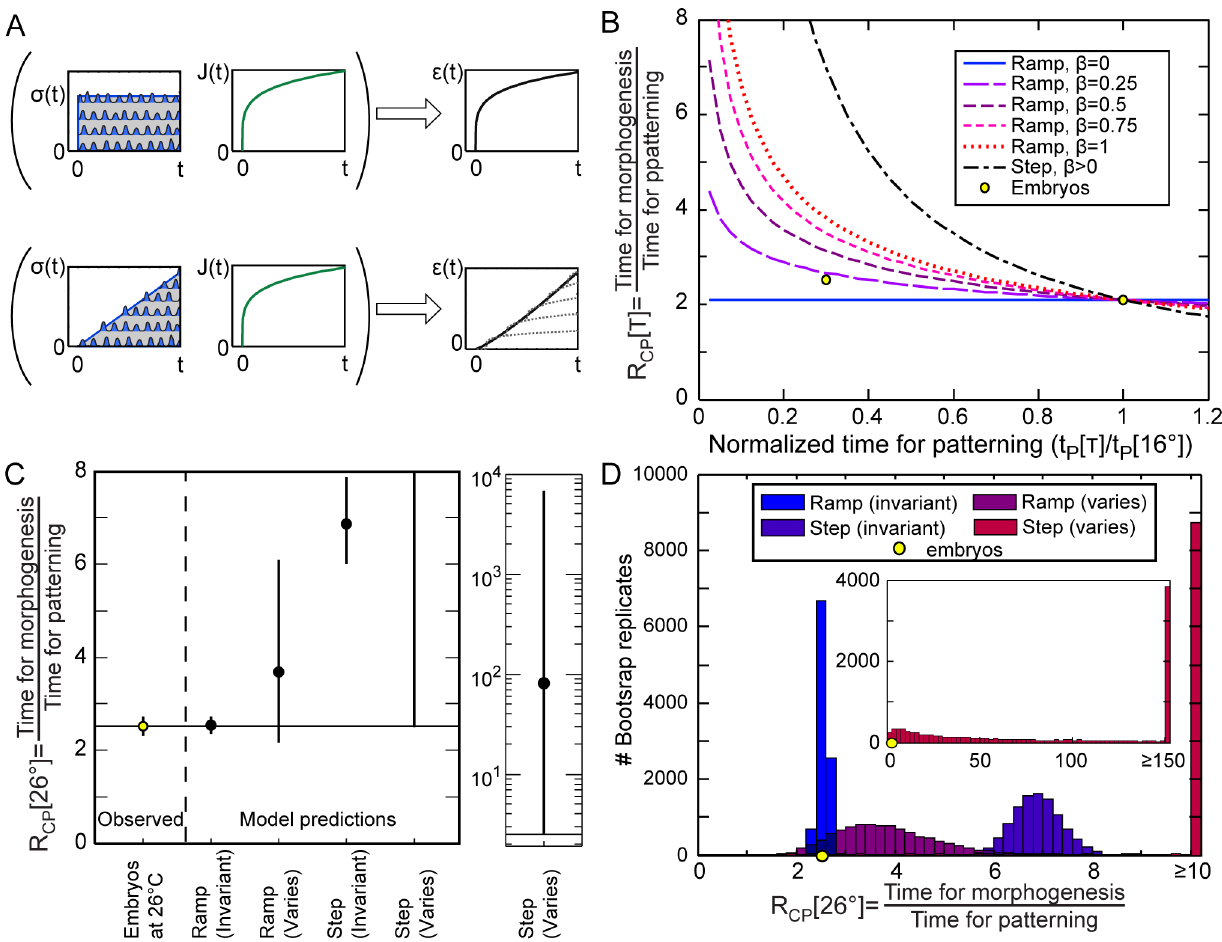
Figure 3. Comparison of viscoelastic models of morphogenesis for ramped versus stepped forces. (A) Diagram of model. Summed contractions (wavy lines) average out to stepped or ramped stresses ( s ) depending on when cells begin contracting. When applied to the viscoelastic material with compliance J[t], the deformations (strains, e ) follow the time course of ramped forces more closely than stepped force. This can be visualized as adding up strains due to a series of stepped forces applied over time (dotted lines on right). (B) Predictions for R CP , the ratio of the time for morphogenesis (blastopore closure) to the time for patterning (D-V progression of involution), as a function of the time for patterning at temperature T, normalized to the time for patterning at 16 u C, for ramped vs. stepped models for different values of b . Yellow dots: grand mean of experimentally observed values. The curves automatically converge to the right hand dot (at 16 u C) where T 2 =T 1 since t C at T 1 is used to calculate R CP at T 2 . (C) Comparison of the observed R CP at 26 u C to the predictions for models with ramped or stepped forces, and with temperature invariant or varying mechanical properties (inset: prediction for stepped force model with temperature dependent mechanical properties on a log scale.) Error bars indicate confidence intervals. (D) Histogram of bootstrap resampling estimates of R CP at 26 u C for each model (10,000 resamples total).